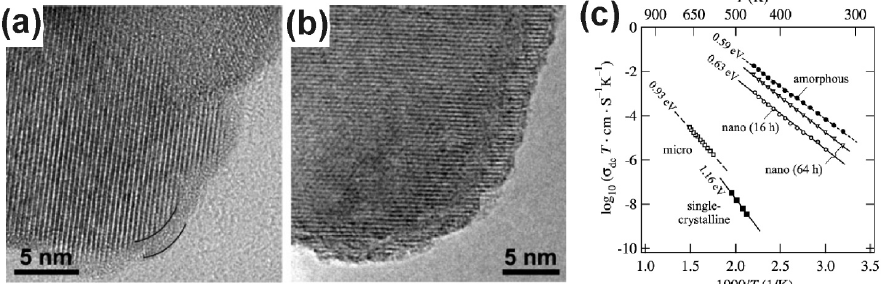
Figure 8. ( a ) Transmission electron microscopy image of the core–shell structure of the LiNbO 3